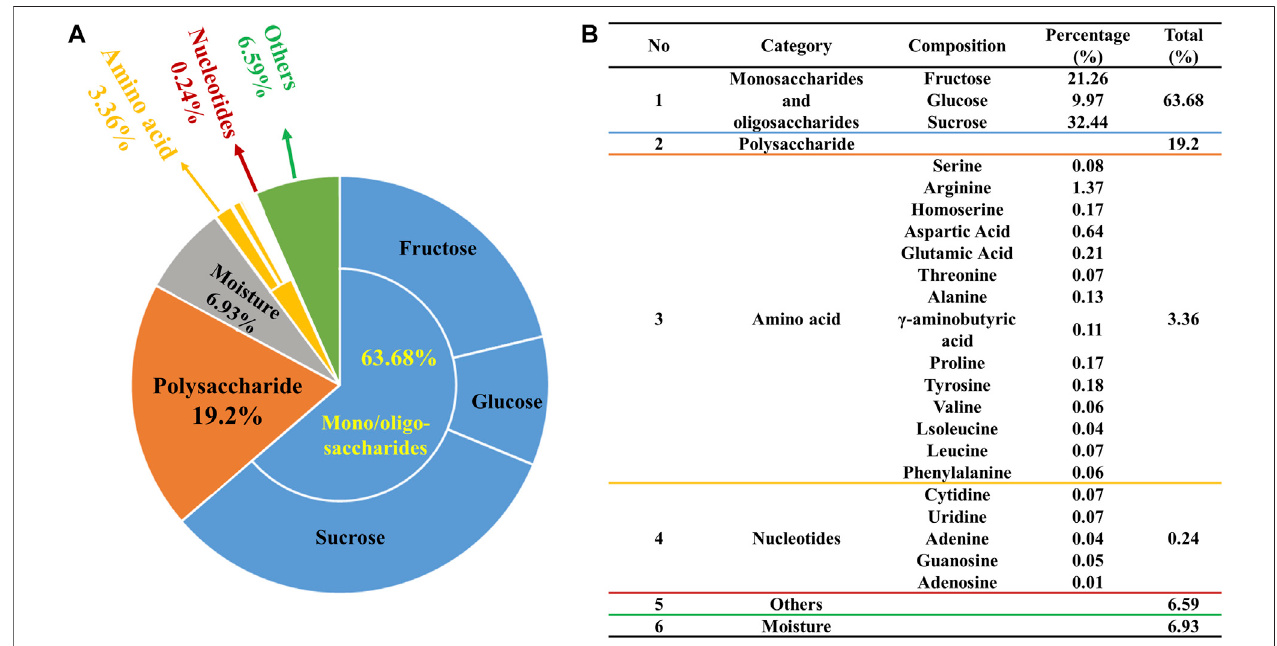
FIGURE 1 | Quantitative characterization of ZXBZ decoction. Distribution of (A) the general and (B) speci fi c chemical composition of ZXBZ decoction.